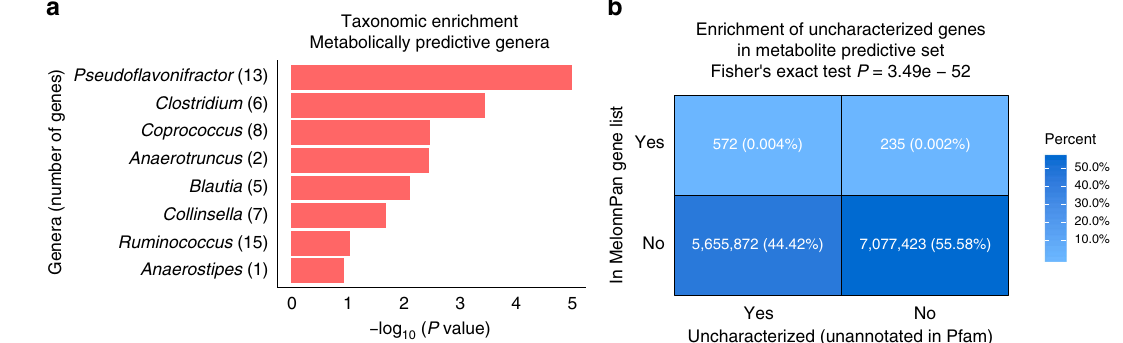
Fig. 3 MelonnPan reveals biologically meaningful functional relationships. a Statistically signi fi cant gene sets (genera) ( Q < 0.25) enriched in the MelonnPan predictive gene list, as identi fi ed by the permutation-based Kolmogorov – Smirnov (KS) test (based on 100,000 null permutations). The bars in the x axis indicate the logarithm of P values calculated as the fraction of permutation values that are at least as extreme as the original KS statistic derived from the non-permuted data. Numbers in the parentheses indicate the size of the gene sets. b Statistically signi fi cant over-representation of uncharacterized gene families in MelonnPan gene set. Contingency table describing the relationship between class membership in Pfam database and metabolite predictiveness reveals enrichment of uncharacterized proteins in the metabolite prediction